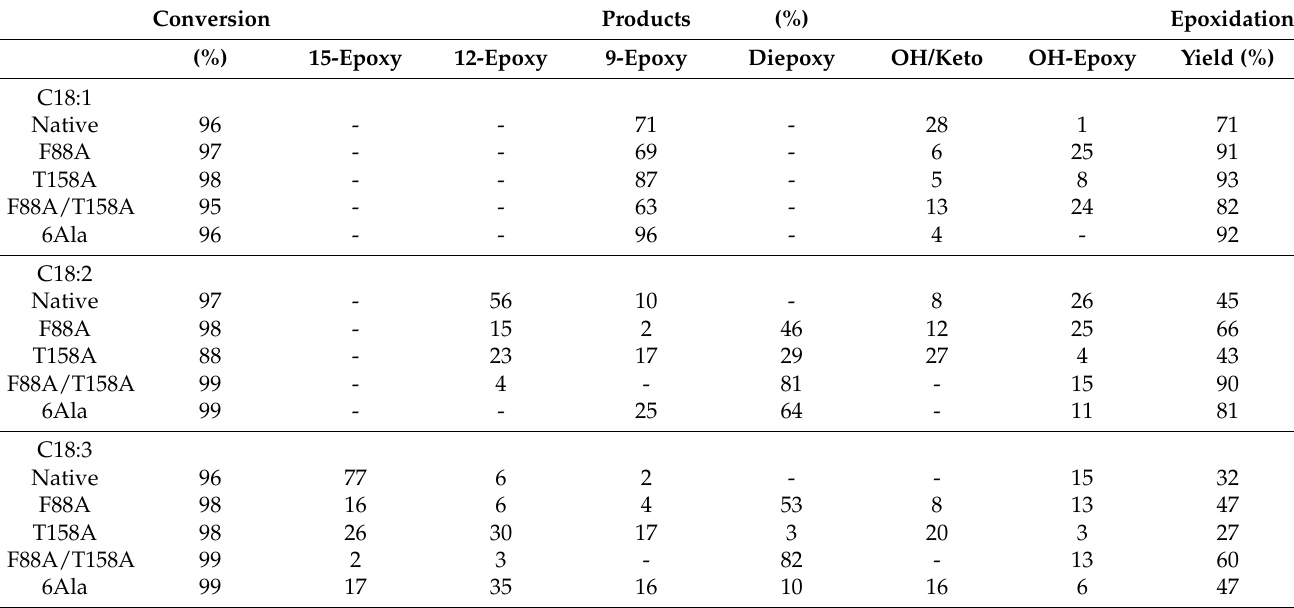
Table 3. Fatty acid conversion, percentages of main products, and epoxidation yield (calculated with respect to the total number of double bonds present) in the reactions of 18-C fatty acids with native r Cvi UPO and four heme channel